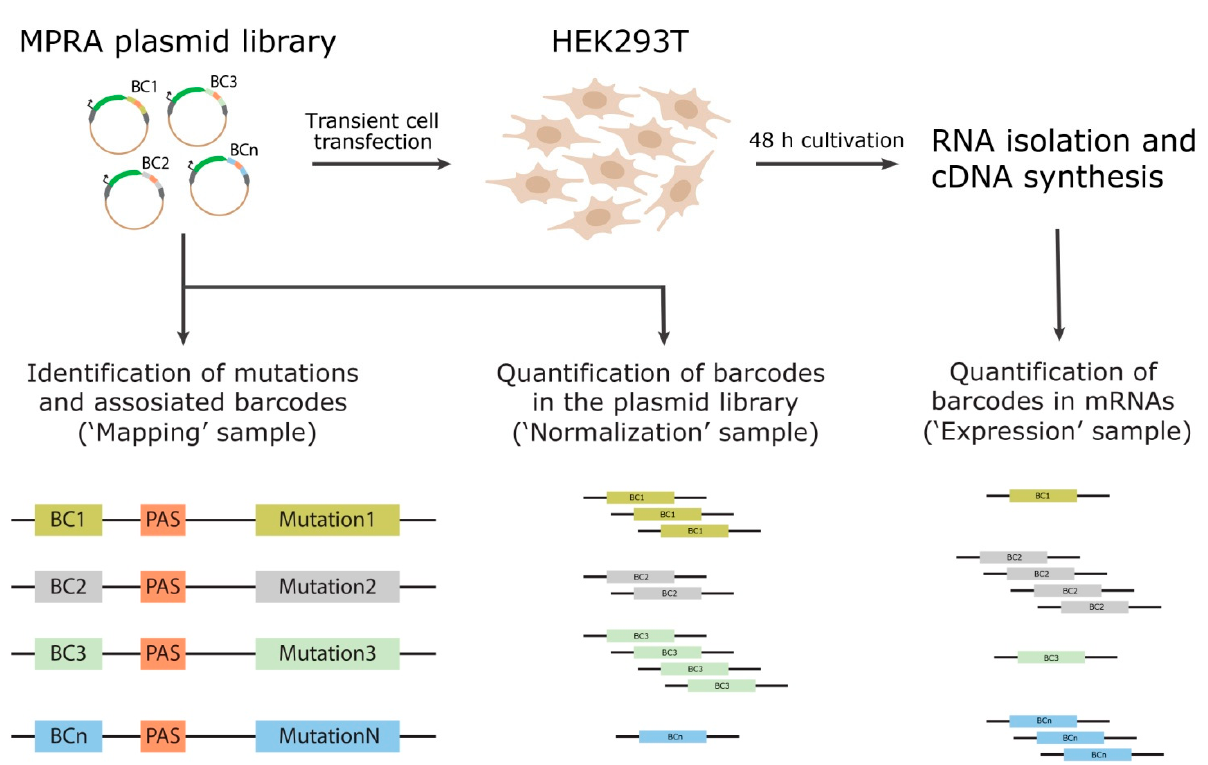
Figure 2. Schematic showing the experimental steps involved in the preparation of MPRA samples for subsequent NGS analysis. BC—barcode; PAS—polyadenylation signal. Table 1. Numbers of unique mutations and associated BCs for each MPRA